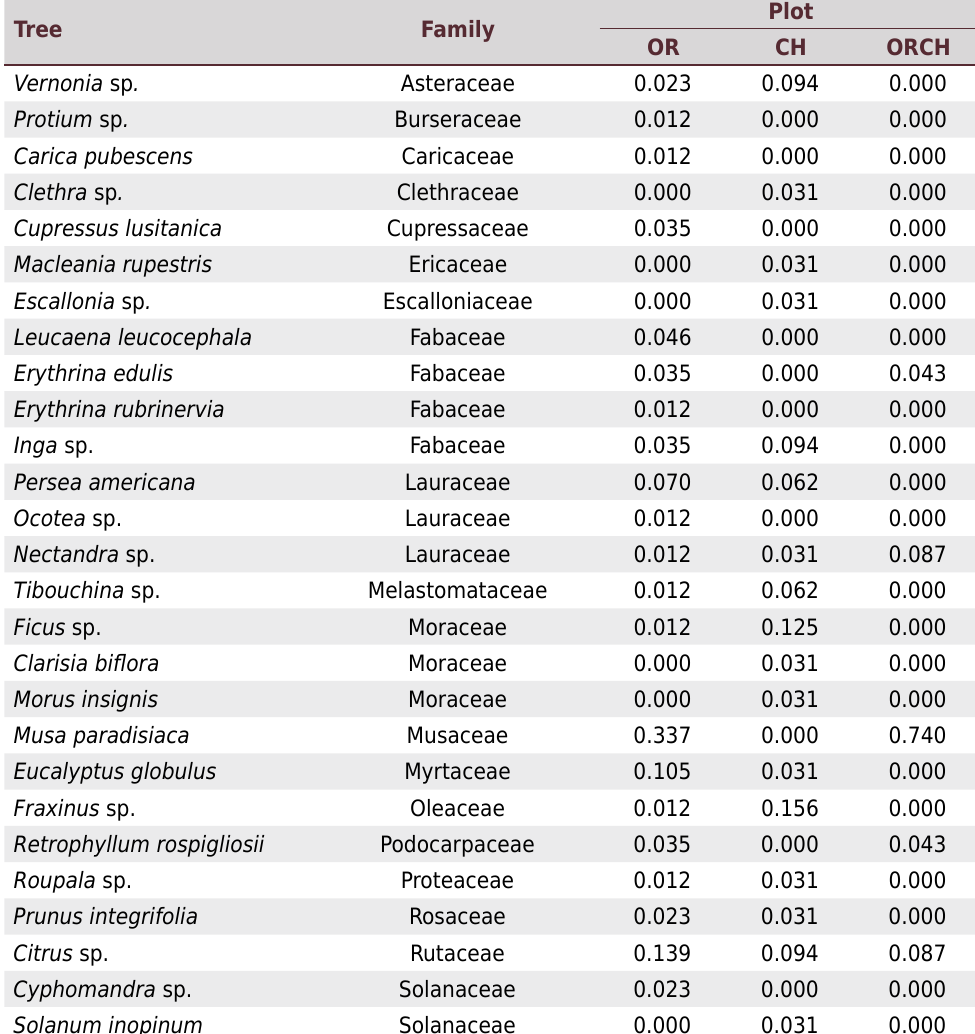
Table 2. Relative frequency of coffee shade trees and associated plants in sampled plots Tree Family